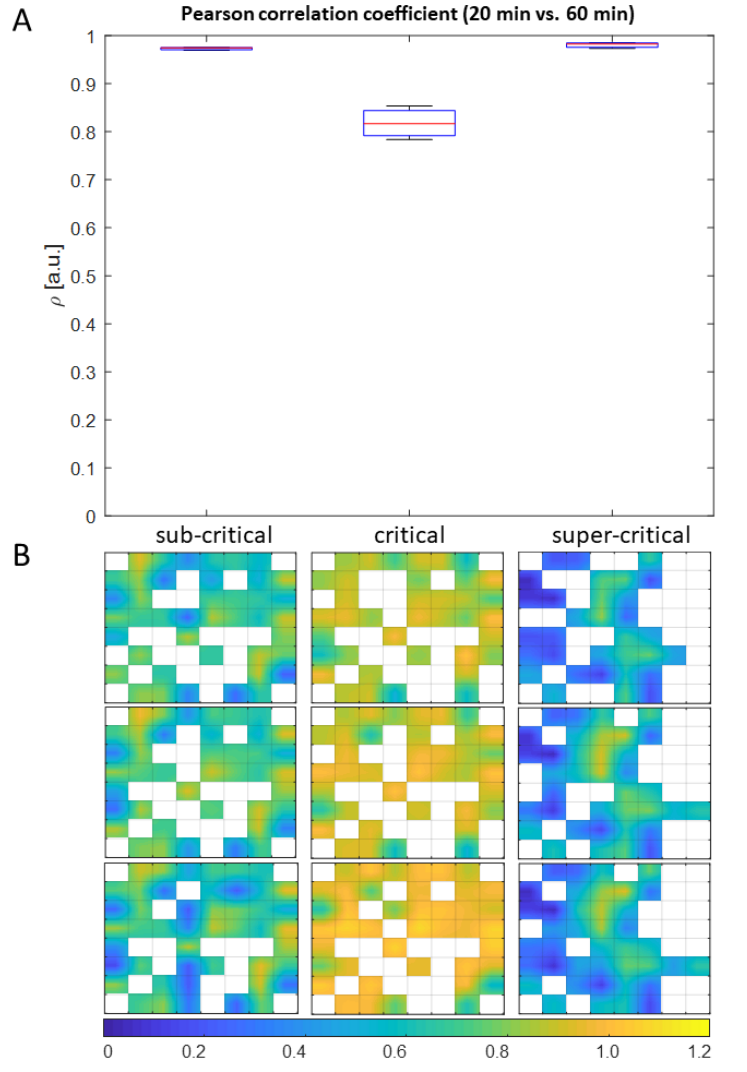
Figure 4. ( A ) Distributions of the Pearson correlation coefficients computed among each one of the 20 min sub-recordings constituting the full-length record (60 min) and the full length record itself. ( B ) Colour maps triplets (one for each culture) showing ApEn estimations on the three contiguous 20 min’